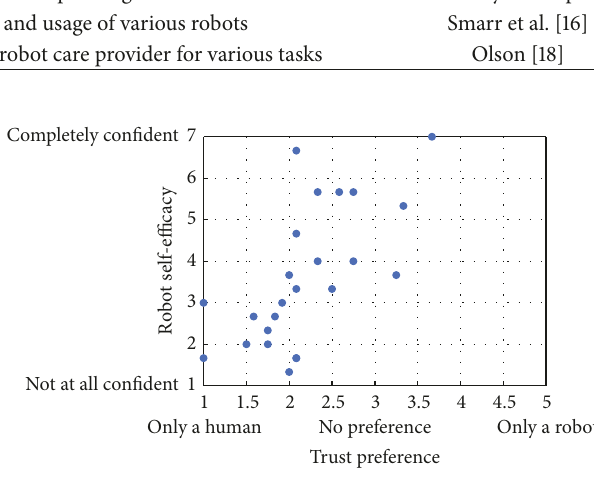
Figure 1: Relation of self-efficacy to trust